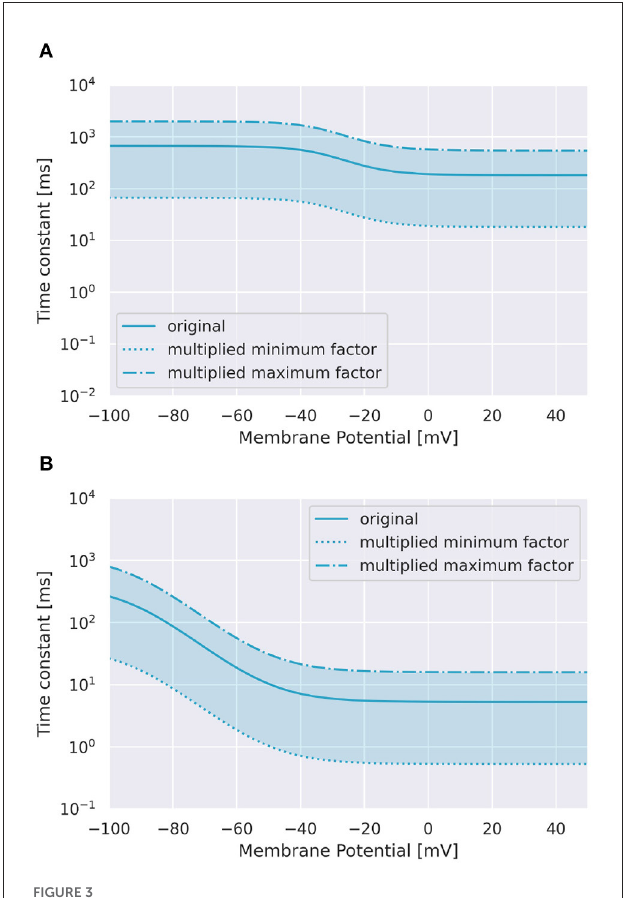
FIGURE3 Range of inactivation time constants changed in the simulation. (A) CaP channel. (B) CaT